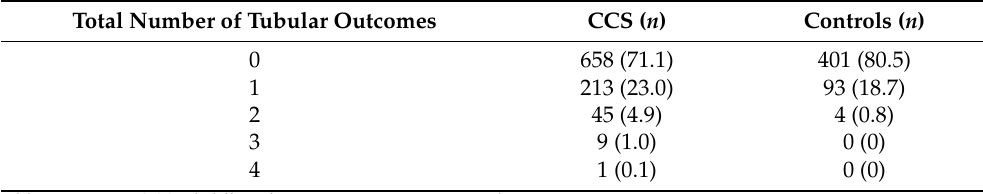
Table 5. Relation between glomerular function and tubular outcomes in childhood cancer survivors and controls. Table 4. Total number of tubular outcomes in childhood cancer survivors and matched controls.